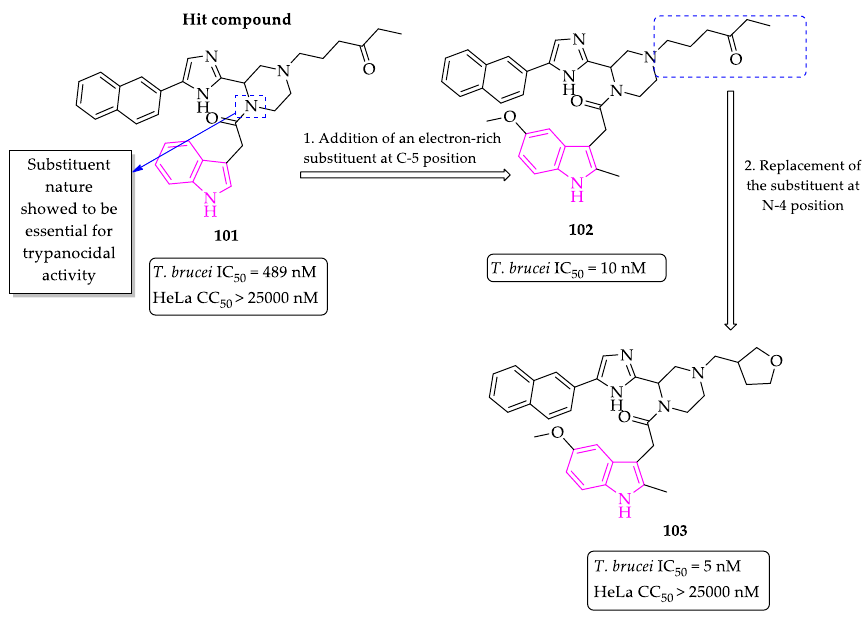
Figure 15. Optimization of compound 101 .